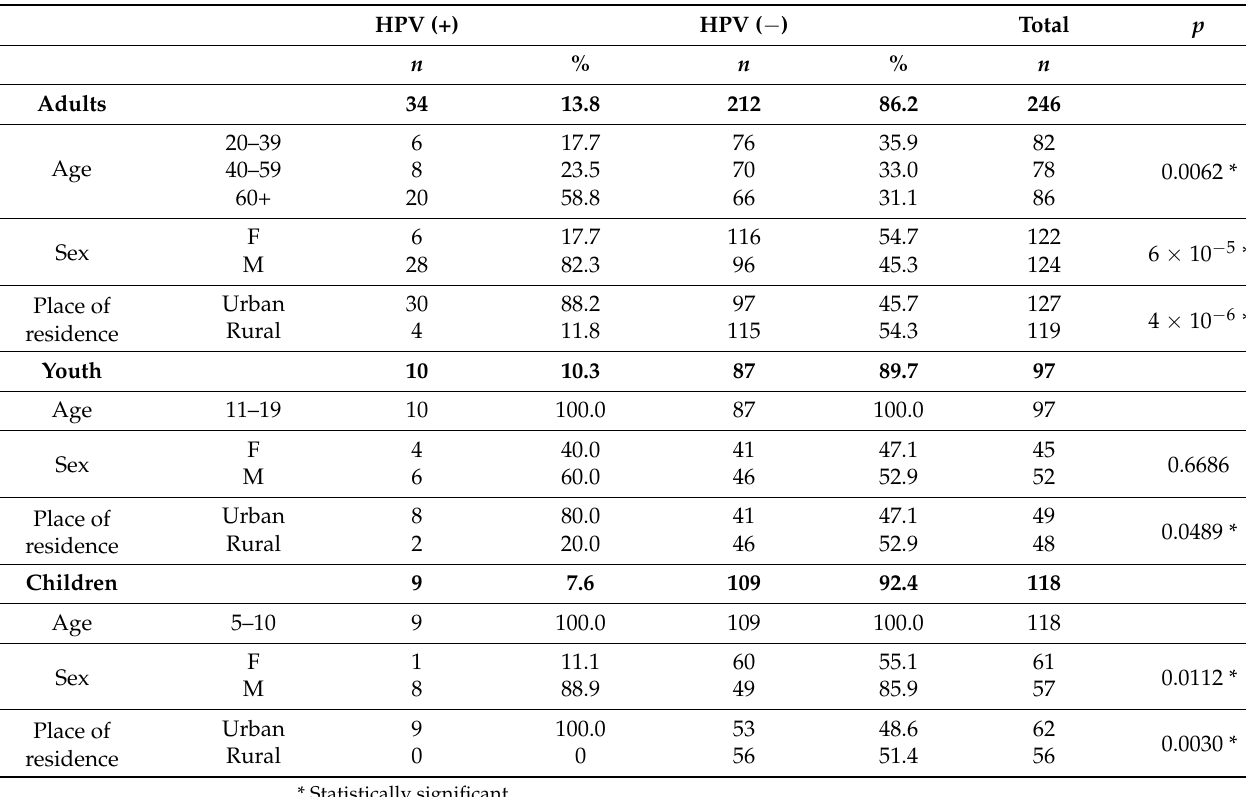
Table 1. Prevalence of HPV in oral cavity and socio-demographic features.